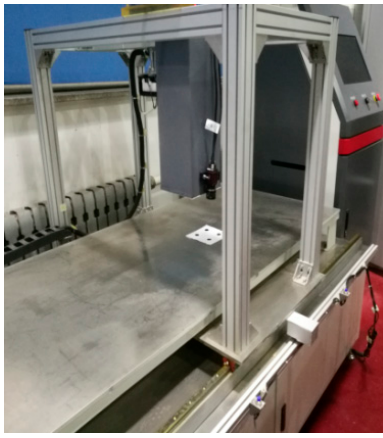
Figure 9. Experimental platform.